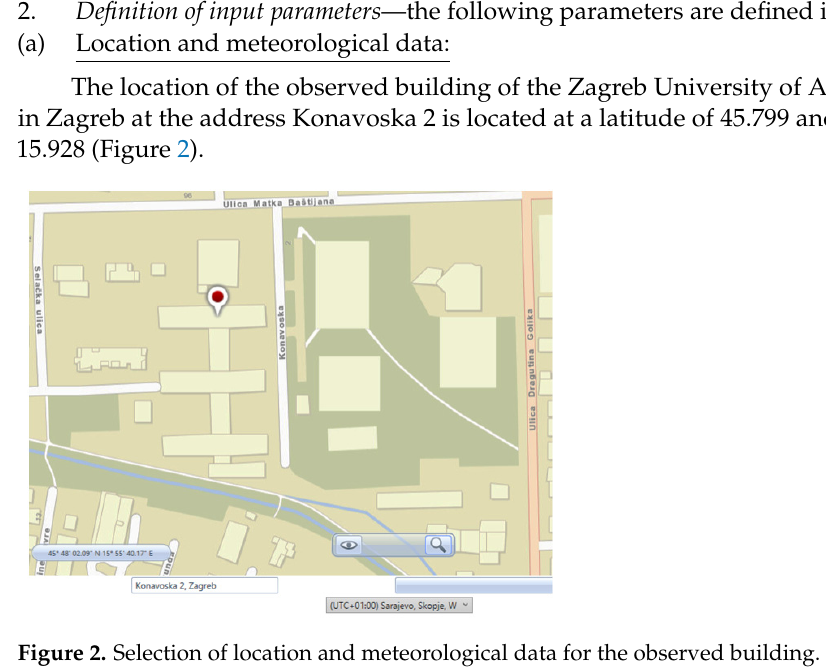
figures (Figures 3–5).